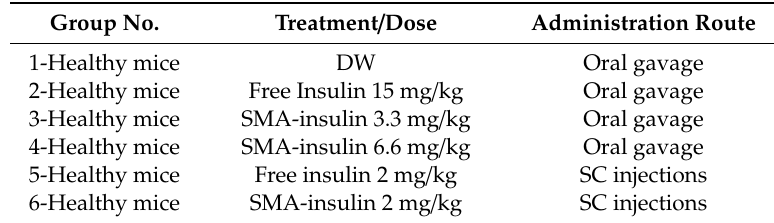
Table 1. Insulin and SMA-insulin treatment groups for non-diabetic mice. Group No.